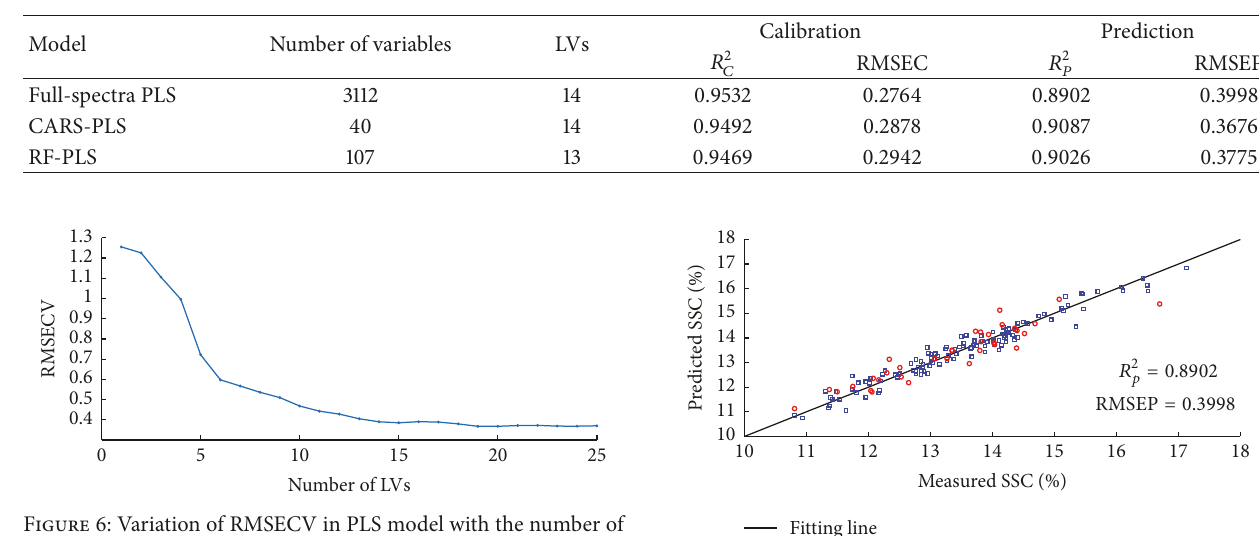
Table 3: The prediction results of apple SSC by different PLS models.